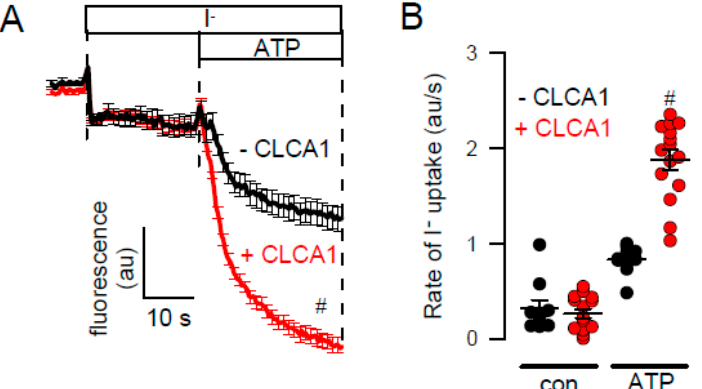
Figure 7. Increase in halide conductance by CLCA1. A , B ) ATP (5 µM) induced iodide quenching of YFP in HT 29 cells. Exposure of the cells for 24h to CLCA1-enriched media augmented ATP induced halide quenching. Mean ± SEM ( n = 10–15). # significant difference when compared to the absence of CLCA1 ( p < 0.05; unpaired t -test).